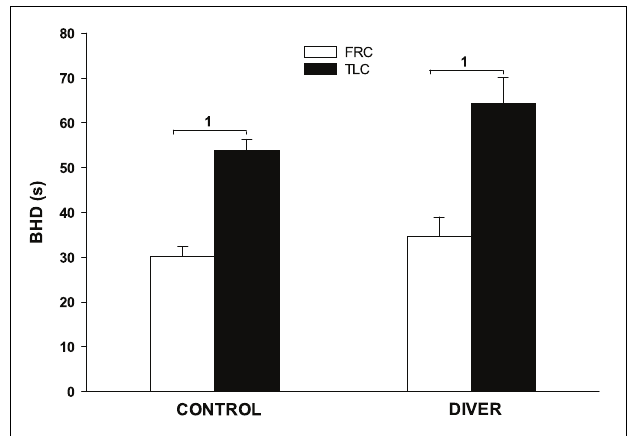
FIGURE 5 | Face immersion into room temperature water at TLC significantly increases BHD in both controls and divers. 1, BHD is significantly longer at TLC vs.